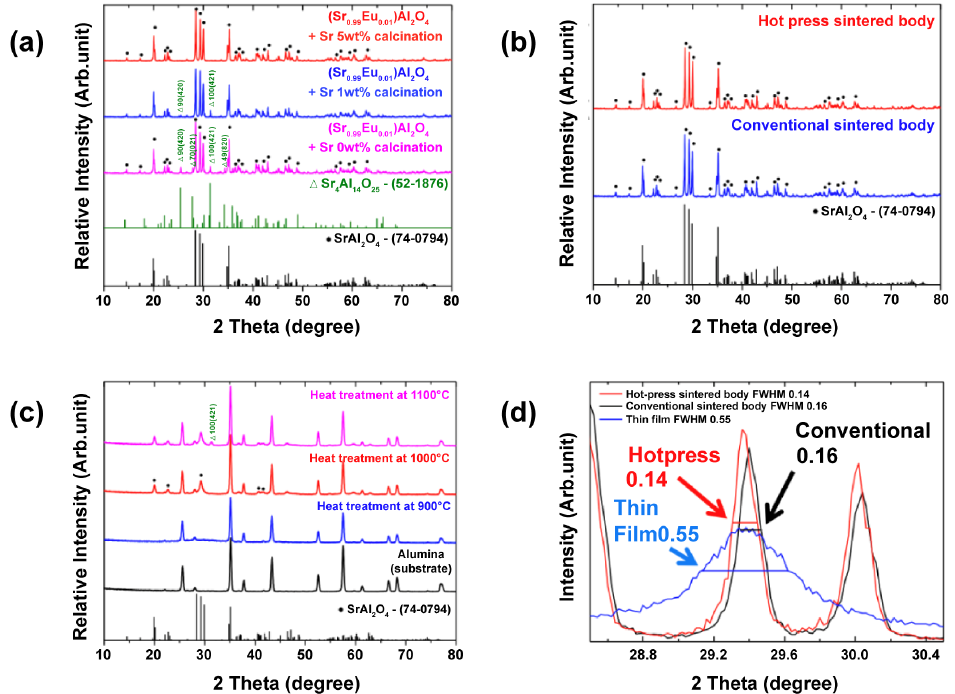
Figure 2. ( a ) X-ray diffraction (XRD) patterns of (Sr 0.99 Eu 0.01 )Al 2 O 4 powder calcined at 1350 °C. ( b ) XRD patterns of a (Sr 0.99 Eu 0.01 )Al 2 O 4 -sintered body at 1400 °C. ( c ) XRD patterns of (Sr 0.99 Eu 0.01 )Al 2 O 4 thin films deposited on alumina substrates and annealed at 900 °C, 1000 °C, and 1100 °C. ( d ) The full width at half maximum (FWHM) of (Sr 0.99 Eu 0.01 )Al 2 O 4 samples obtained from the XRD patterns (2 θ = 29.4°).